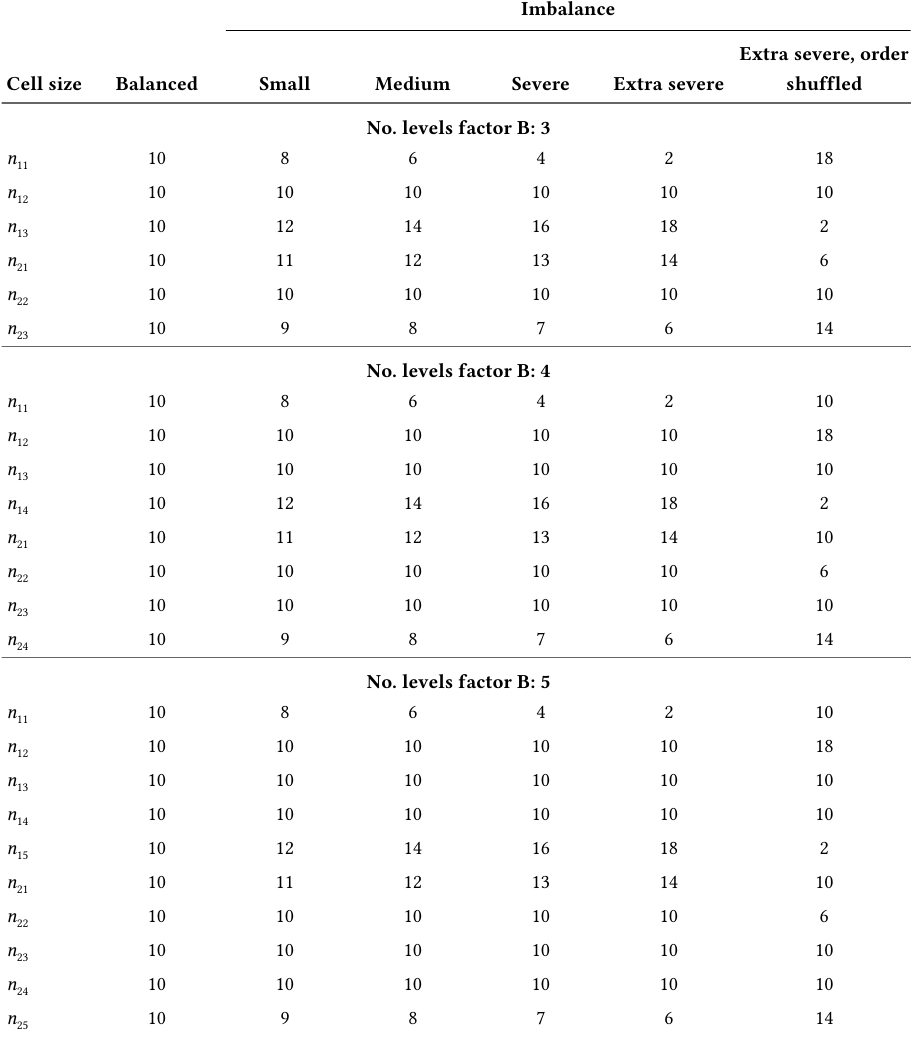
Cell Sizes for Different Degrees of Imbalance Under a Small Sample